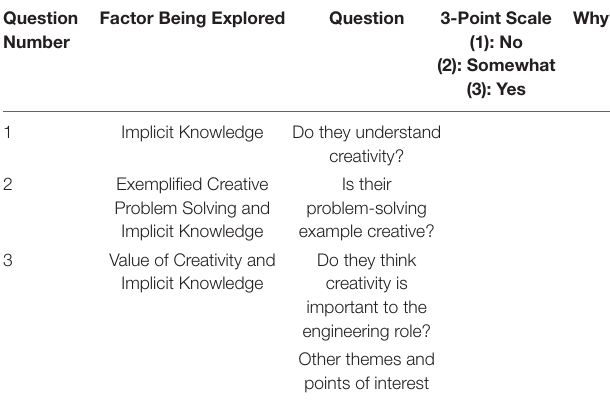
TABLE 3 | Scoring rubric for RQ1, RQ2, and RQ3 ranking and additional theme